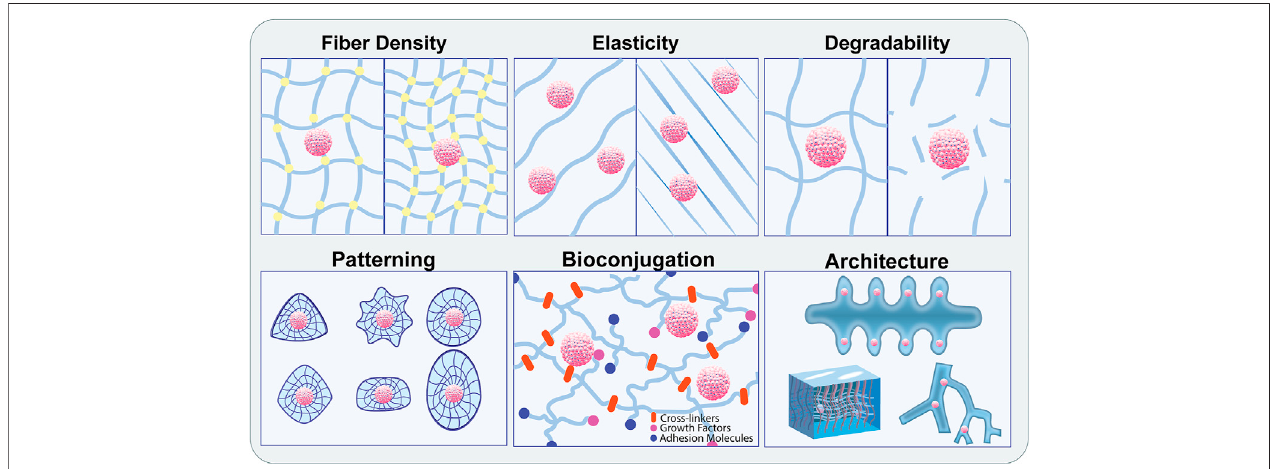
FIGURE 3 | Modi fi cation of biomaterials to recapitulate the physiological stem cell niche. Biomaterial engineering approaches enable precise control over the biophysical properties of the ECM components leveraged to recreate the physiological stem cell niche. Material properties include fi ber density, crosslinking, stiffness, elasticity, and degradability. These can be adjusted individually or in combination with patterning, bioconjugation, and pre-de fi ned architecture to promote specialized organoid assembly and stem cell maintenance.